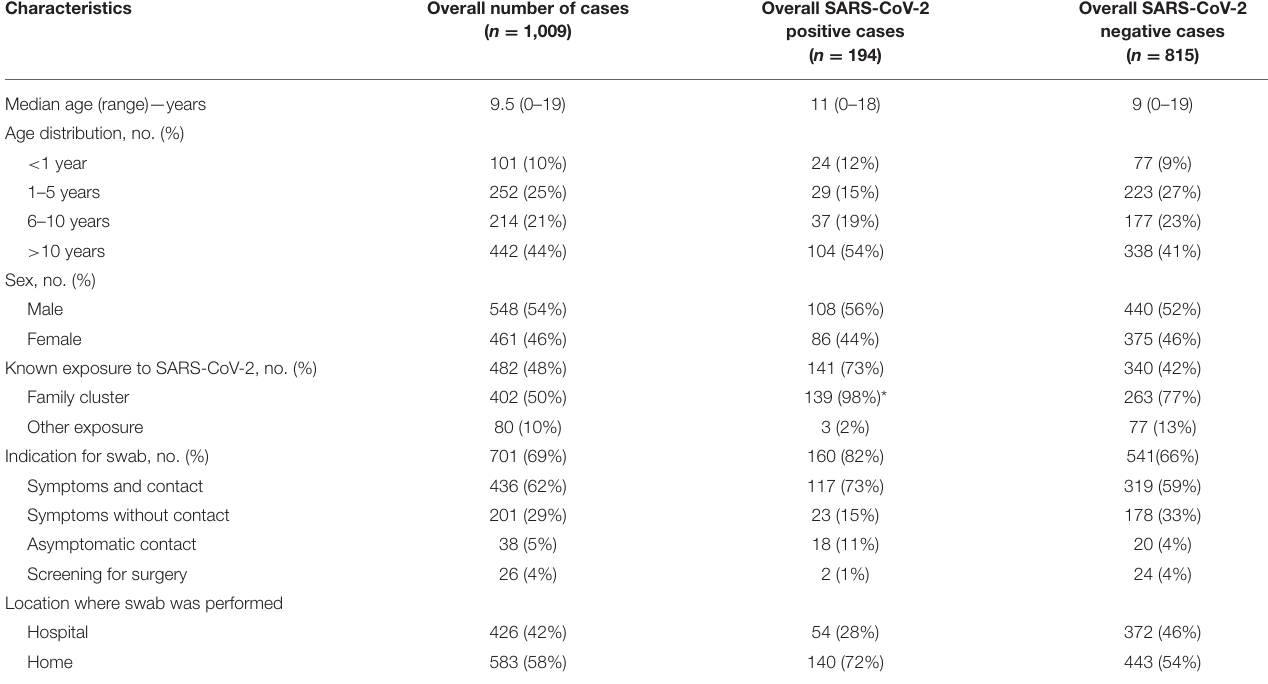
TABLE 1 | Characteristics of children with suspected severe acute respiratory syndrome coronavirus 2 (SARS-CoV-2) infection in the Emilia-Romagna Region, Italy.